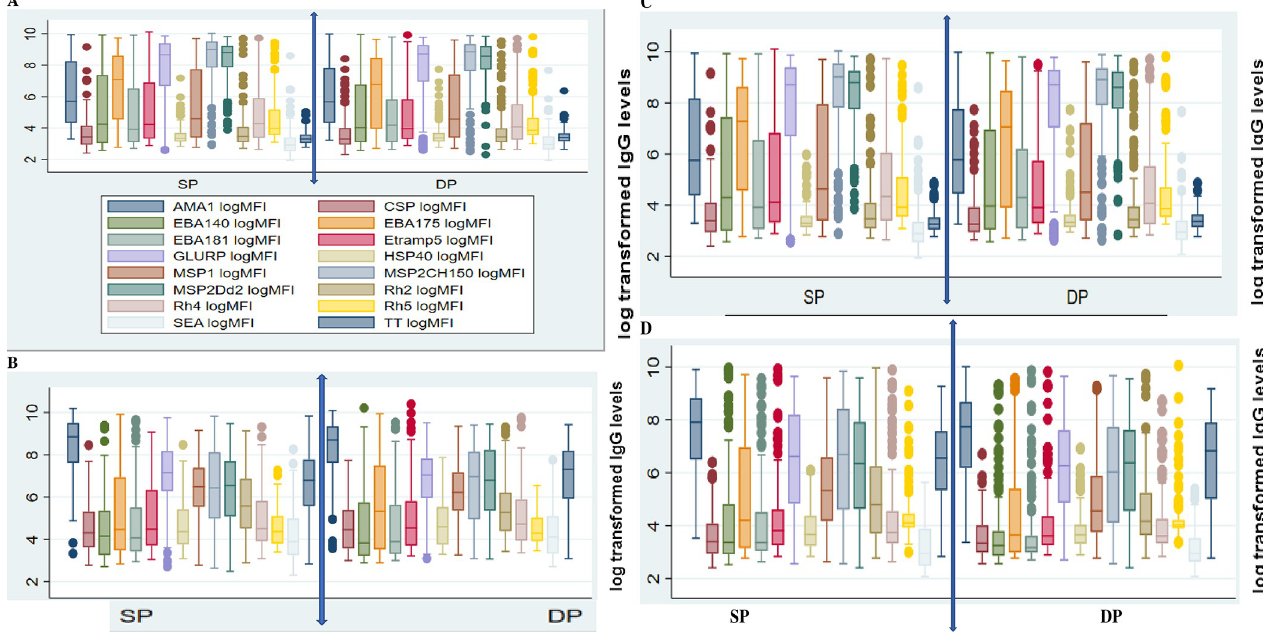
Fig 1. Effects of mother’s IPT arm on cord levels of IgG sub-types. (A) comparison for IgG1; DP versus SP; (B) comparison of the two groups for IgG2; (C) effects of IPT use on IgG3 cord level; (D) comparison of the effects of the two groups of prophylaxis on IgG4 (all Y axes are in log MFI).